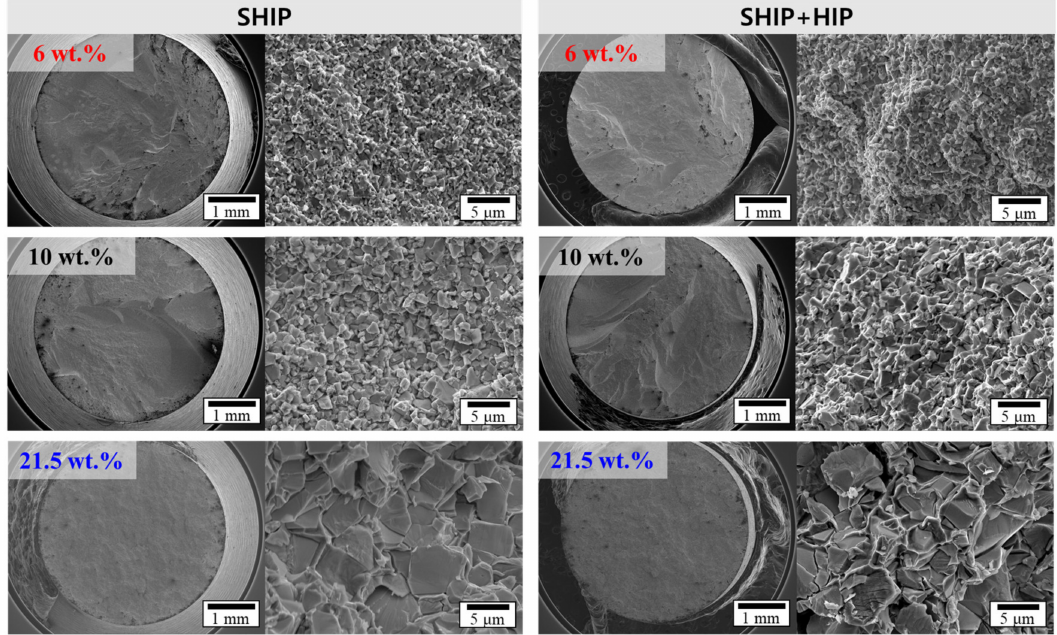
Figure 11. Comparison of SEM micrograph maps of WC-Co according to the Co content and HIP